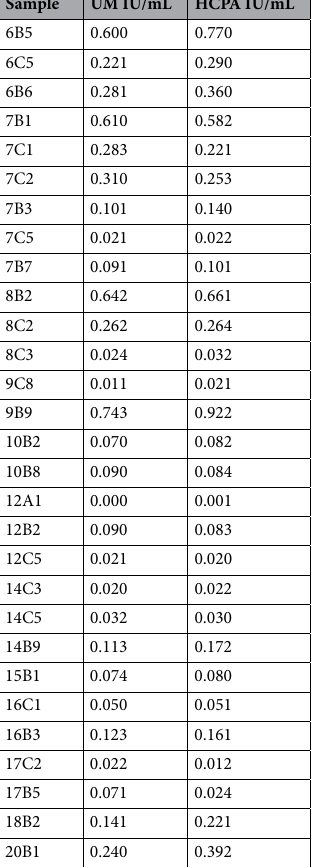
Table 3. Comparative results of Escherichia coli -derived ASNase activity (IU/mL) between the University of Munster (UM, Munster, Germany) and Hospital de Clínicas de Porto Alegre (HCPA, Porto Alegre, Brazil). UM